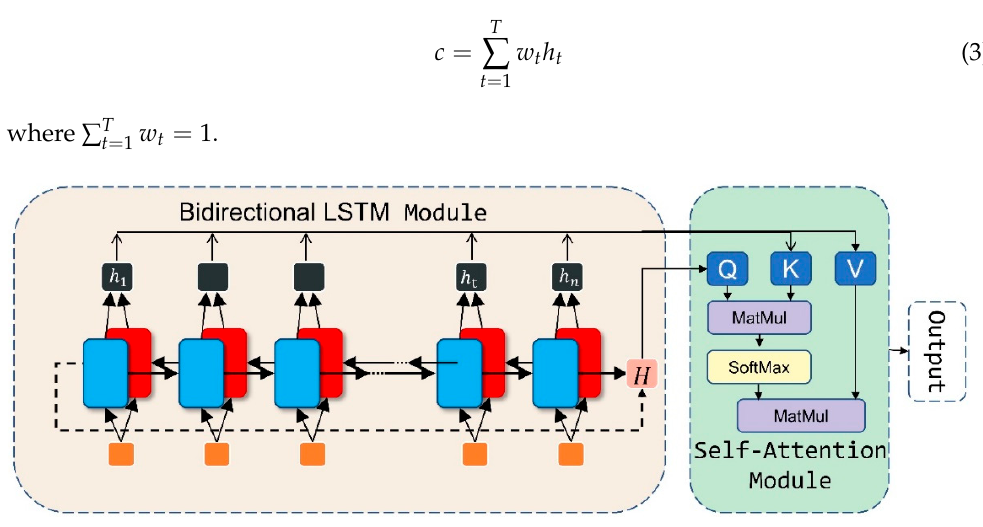
Figure 4. The self-attention mechanism.